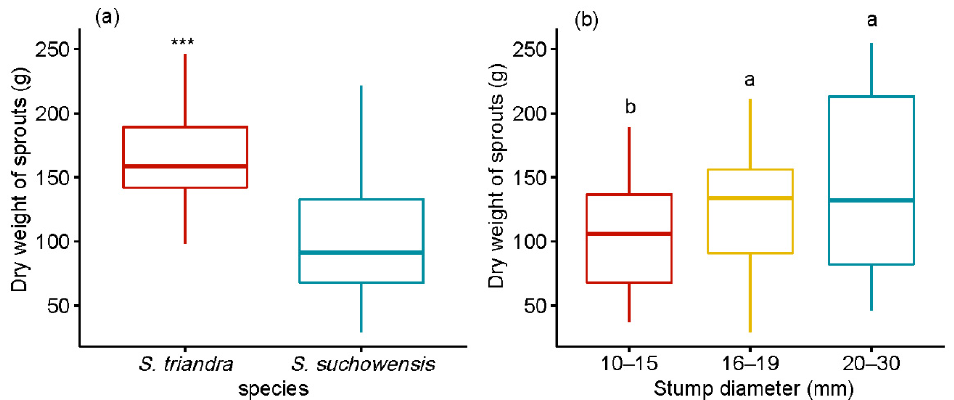
Figure 3. Effect of stump diameter and species on ground dry biomass of sprouts. Notes: Comparisons between species within ground dry biomass of sprouts were performed using the pairwise t -test. *** p < 0.001. Different letters above bars indicate statistical differences among stump diameter classes according to Tukey’s HSD mean comparison.